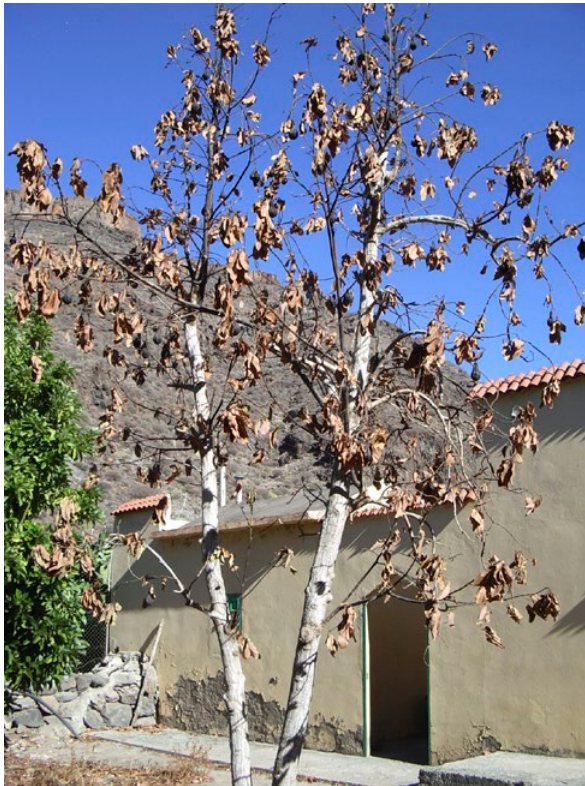
Figure 5. Avocado tree in advanced decline infected with P. niederhauserii ; isolate C051 was obtained from roots that were collected from this tree. No other Phytophthora was detected in the orchard that was located in Mogán (Gran Canaria, Canary